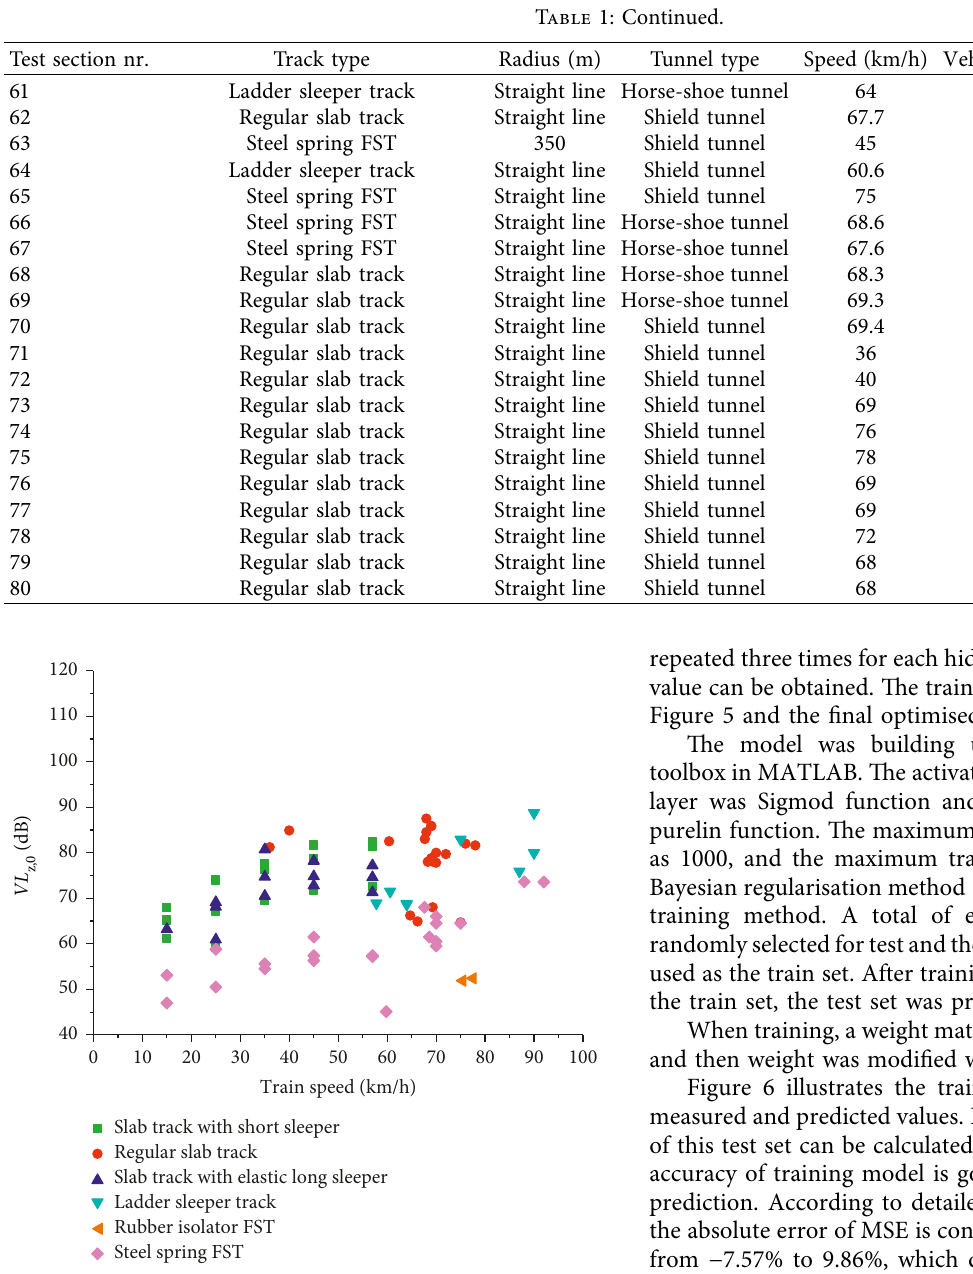
Figure 3: Tunnel vibration responses vary with train